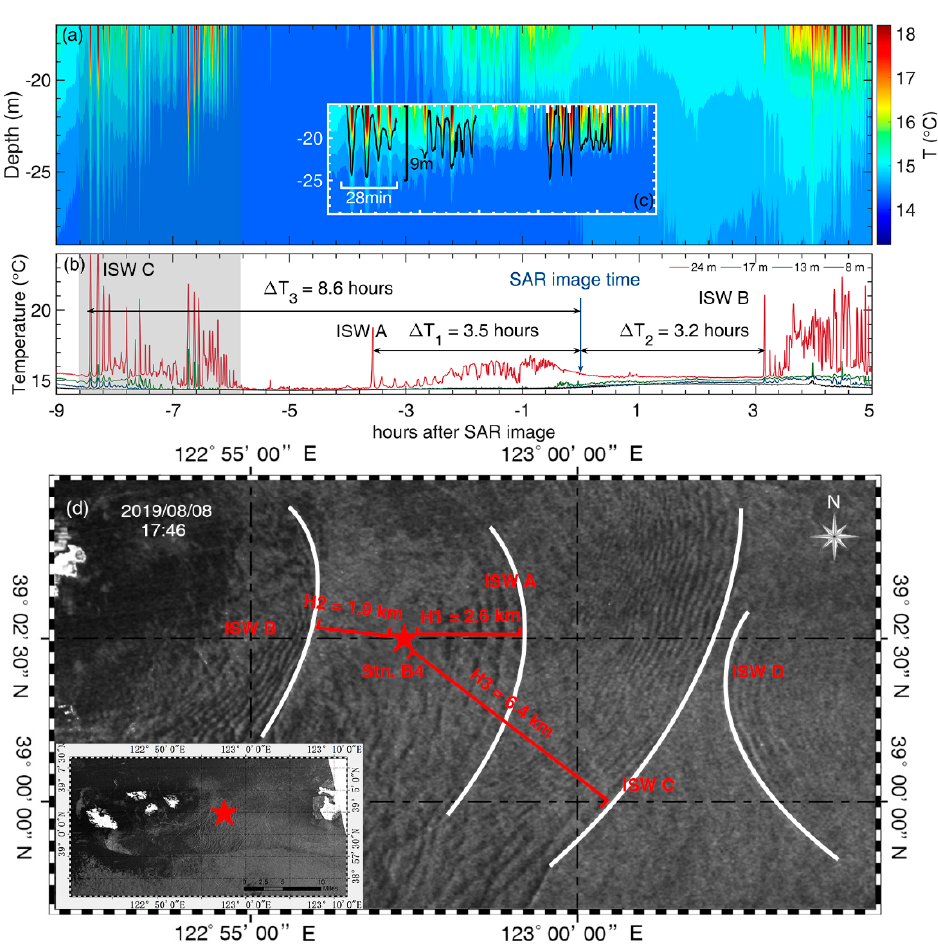
Figure 6. Same as in Figure 5 but for another typical SAR image. The SAR image ( a – d ) was acquired on 8 August 2019 (17:46 UTC + 8).